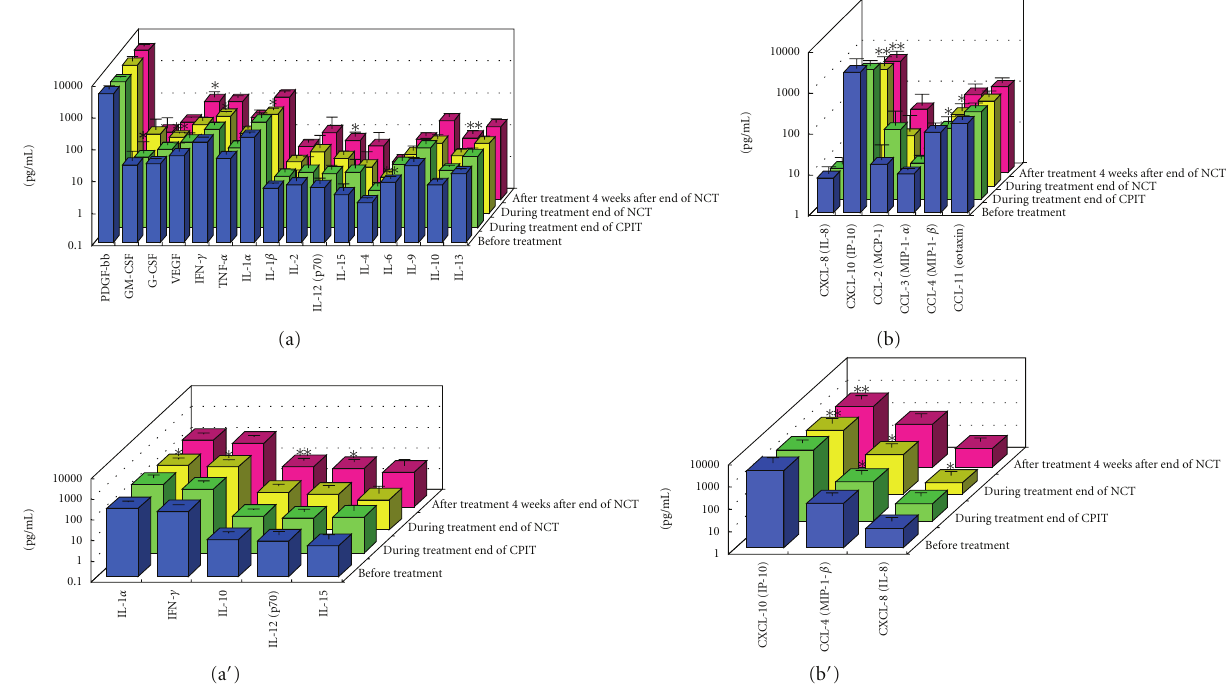
Figure 3: E ff ect of RBV plus PEG-IFN-alpha 2b using an “induction” approach with CPIT (NCT) on serum cytokines (a), (a (cid:3) ), and chemokines (b), (b (cid:3) ) in chronic hepatitis C patients with high viral load, genotype 1b (serotype I), and wild or intermediate types of ISDR (early virological responders). RBV: ribavirin, PEG-IFN: pegylated interferon, CPIT: cyclic and periodic interferon treatment, NCT: novel combination treatment. Significant di ff erence: ∗ P < 0 . 05, ∗∗ P < 0 . 1.